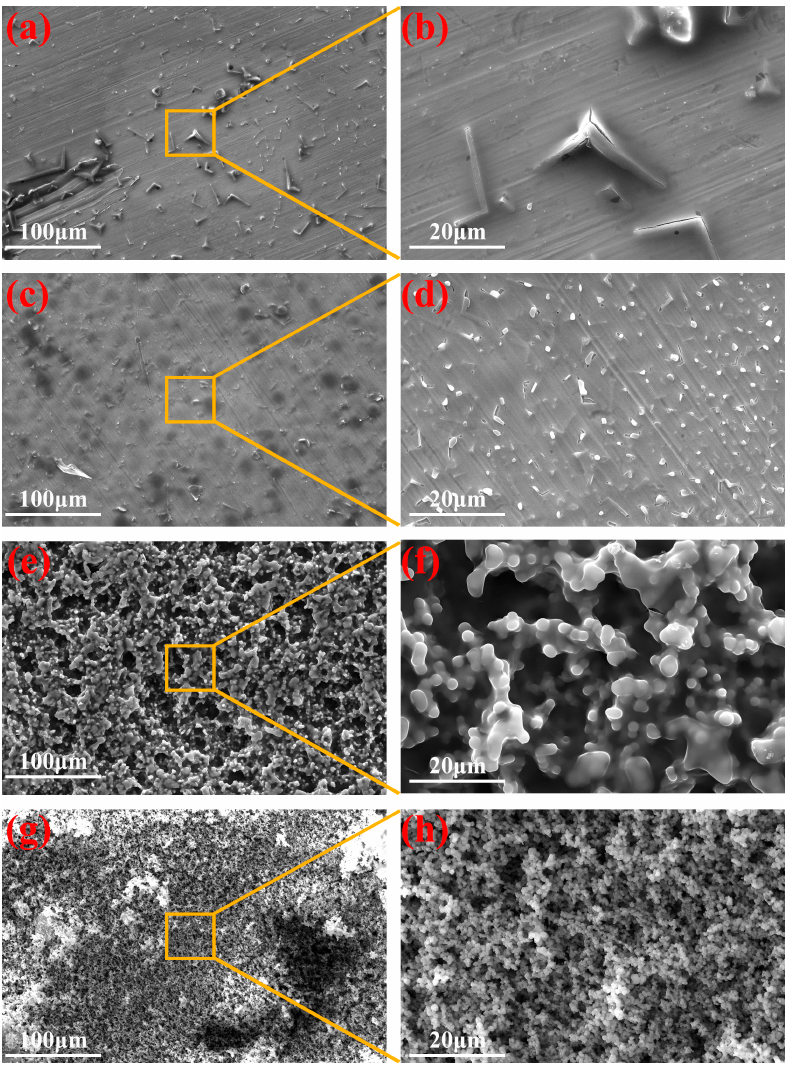
Figure 4. Top-view FE-SEM images of silica films prepared with different deposition potentials: ( a , b ) − 1.0 V; ( c , d ) − 1.1 V; ( e , f ) − 1.2 V; ( g , h ) − 1.3 V. (The deposition time was 600 s for all the samples).